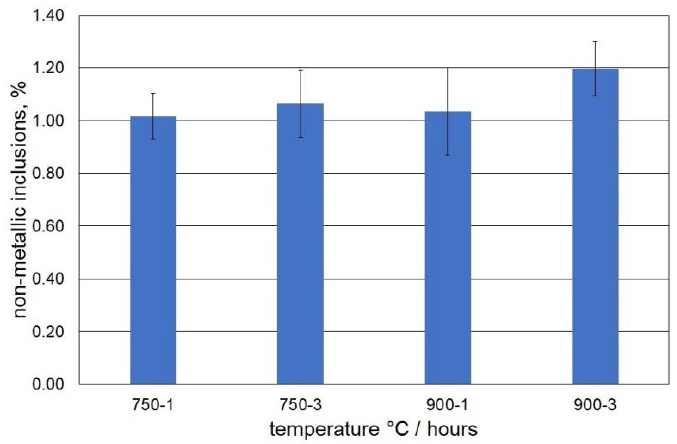
Figure 1. Non-metallic inclusions in the tested cast